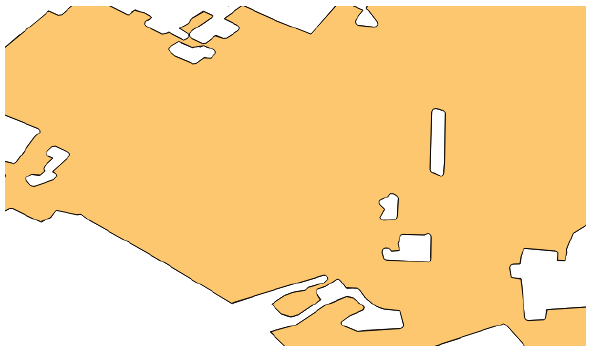
Figure 8. OSM built-up features after processing with a buffer distance x of 25m and a generalization distance of 5m.